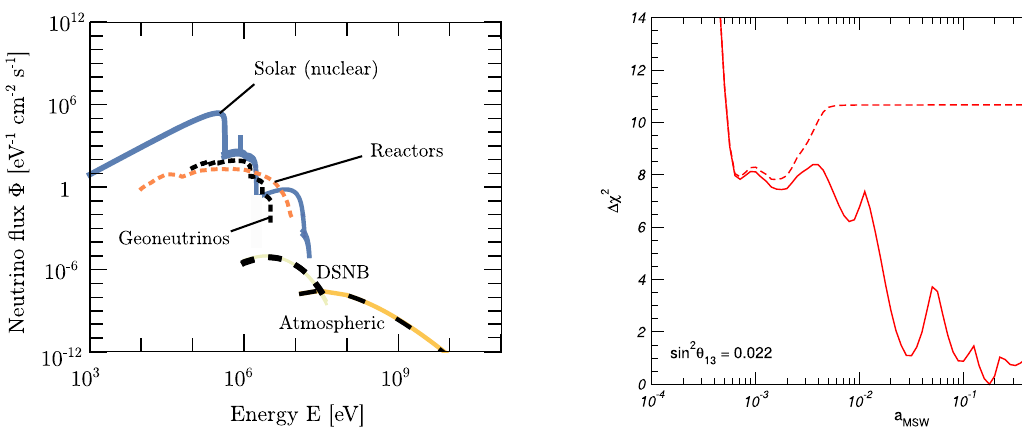
Fig. 11 Complementarity between solar and reactor neutrinos in mea- suring neutrino matter effects. We show (cid:8)χ 2 for solar (red) and Kam- LAND reactor (blue) data as a function of an overall rescaling of the neutrino matter potential by a factor a MSW (in the SM, a MSW = 1). The red dashed line is obtained neglecting Earth matter effects. Figure adapted from Ref.